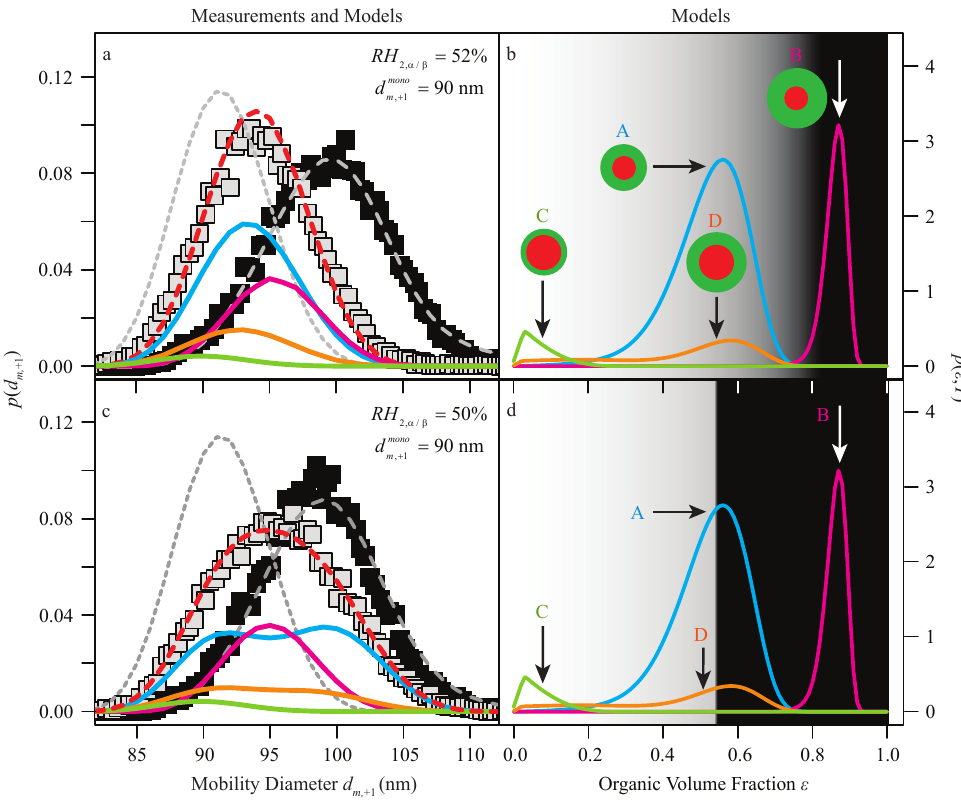
Fig. 3. Examples of data sets and associated analysis for number-diameter distribution experiments. The black squares of (a) correspond to a population in which the ammonium sulfate components of all particles are fully deliquesced because of exposure to 90%RH and the absence of efflorescence at 52%RH. The gray squares correspond to a population in which the ammonium sulfate components of some fraction of the particles are fully deliquesced (i.e., those particles of ε > ε (52%)). That fraction, as well as ε (52%), are unknown prior to D D measurement and analysis. The solid colored lines represent model results for the different particle sub-populations represented in (b) . The dashed lines represent model results for the entire particle population, with the red dashed lines as the sum of the other four colored lines, the short-dashed gray lines as a population in which the ammonium sulfate components of the particles are crystalline, and the long-dashed gray lines as a population in which the ammonium sulfate components of the particles are aqueous. A comparison between the data and the dashed lines is the basis of the DRH( ε ) points shown in Fig. 4 (cf. main text for additional explanation). (b) Probability density functions p ( ε ; T ) for the different particle types that constitute the four particle sub-populations. Cartoons A through D represent these four particle types, for which organic material is in green and sulfate is in red. The background shading represents the dissolved fraction of ammonium sulfate, ranging from zero in white to unity in black (cf. Eq. A3). The ordinate of p ( ε ; T ) for each particle type is scaled to the fractional contribution to the total p ( ε ) (i.e., to the number concentration of the particle sub-population). Panels (c) and (d) are as described for (a) and (b) but for efflorescence measurements. Other differences, especially as related to the gray squares, are described in the main text. For all = panels, d mono m,+1